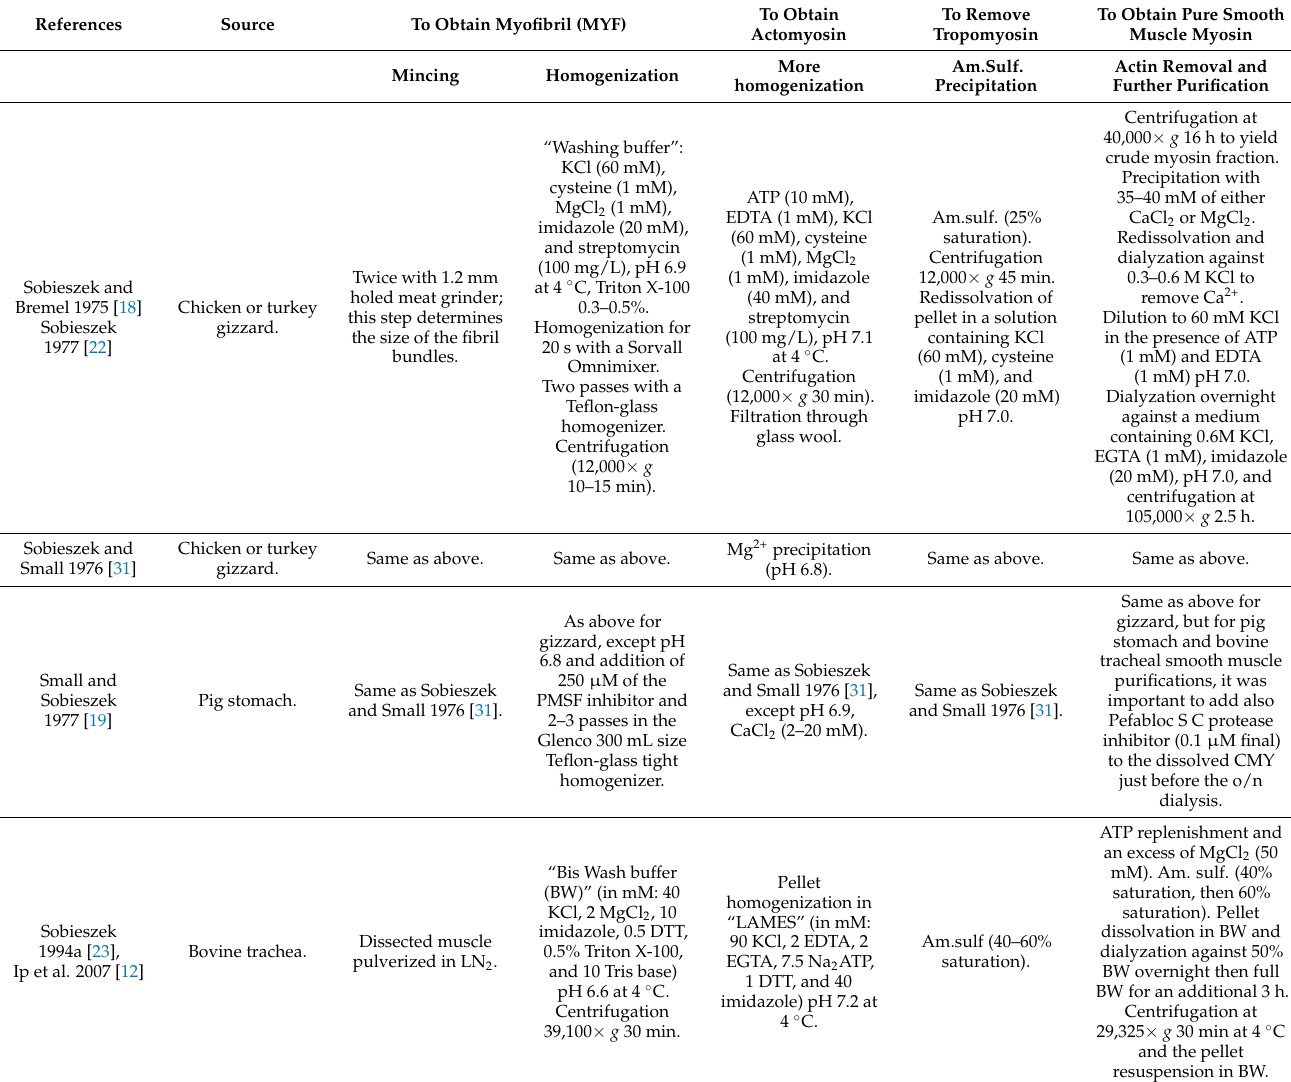
Table 1. The evolvement of Sobieszek myosin purification